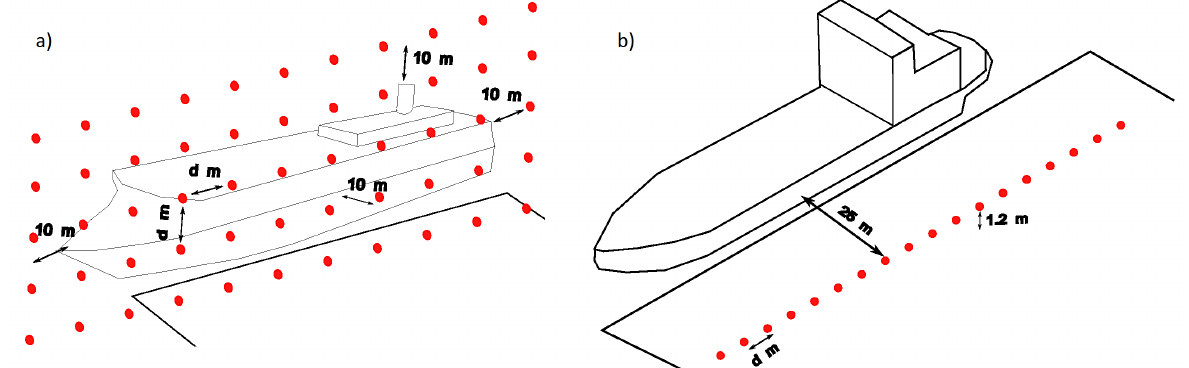
Figure 3: Grid of points for the characterization of airborne radiated noise